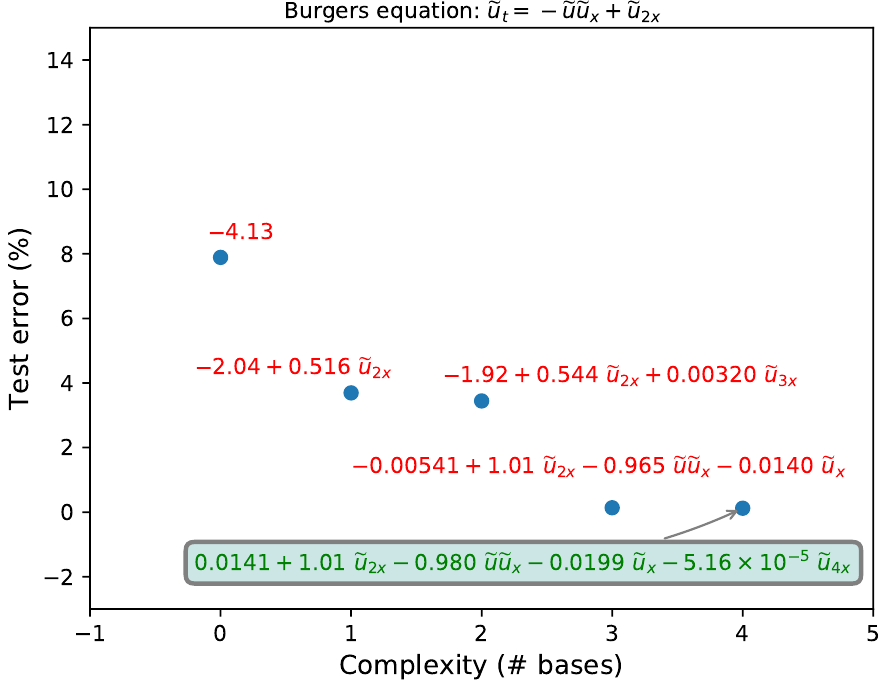
Figure 6. Non-dimensional analytical solution of Burgers equation.